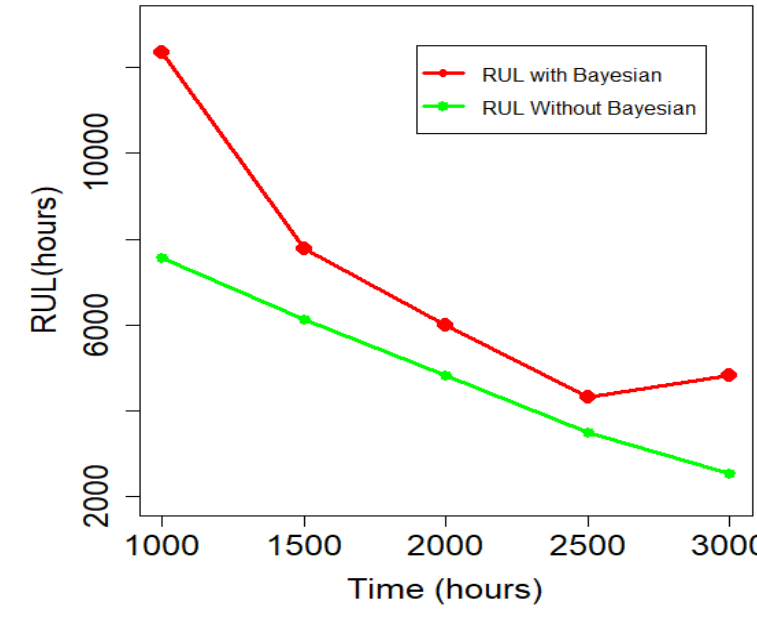
Figure 4. Comparative RUL estimates with and without Bayesian method.